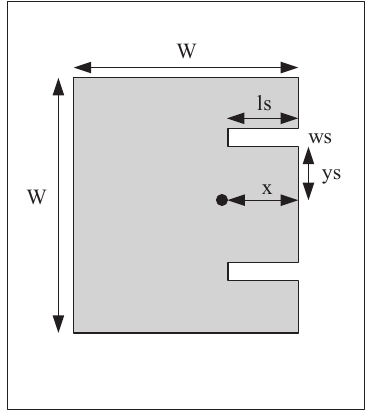
Figure 1. Structure of a microstrip